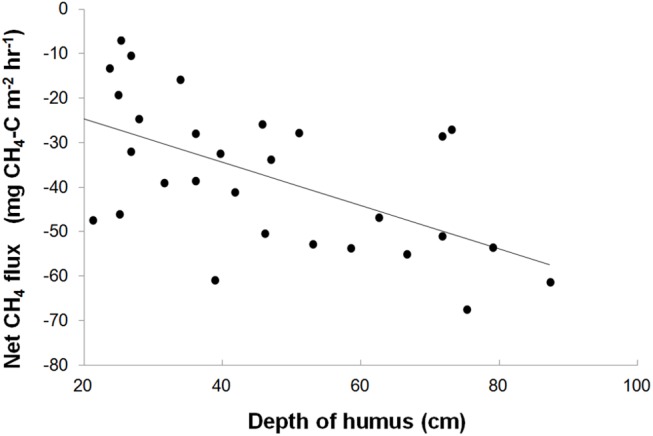
In situ CH4 flux versus depth of humus.
In situ 2006 CH4 flux versus depth of humus (R2 = 0.35; P ≤ 0.001). Each data point represents the mean of five measurements made on each island at the same time. 10 depth measurements were made per island.